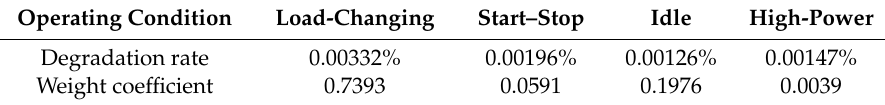
Figure 8. Fuel cell system power.